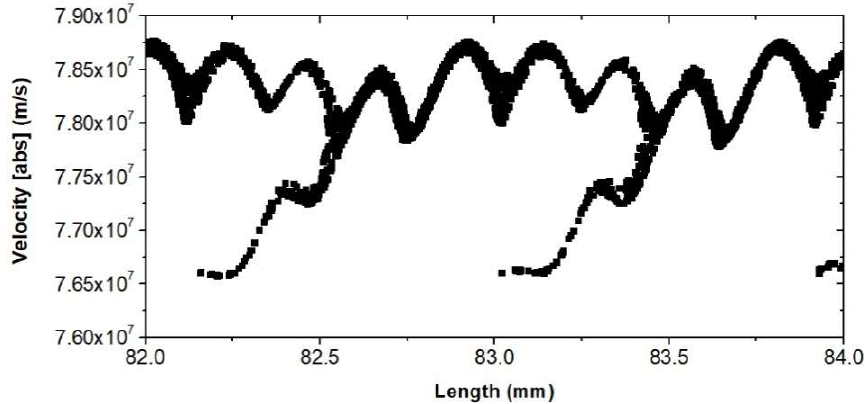
Figure 7. Power curve of the HHTWT at 346 GHz.